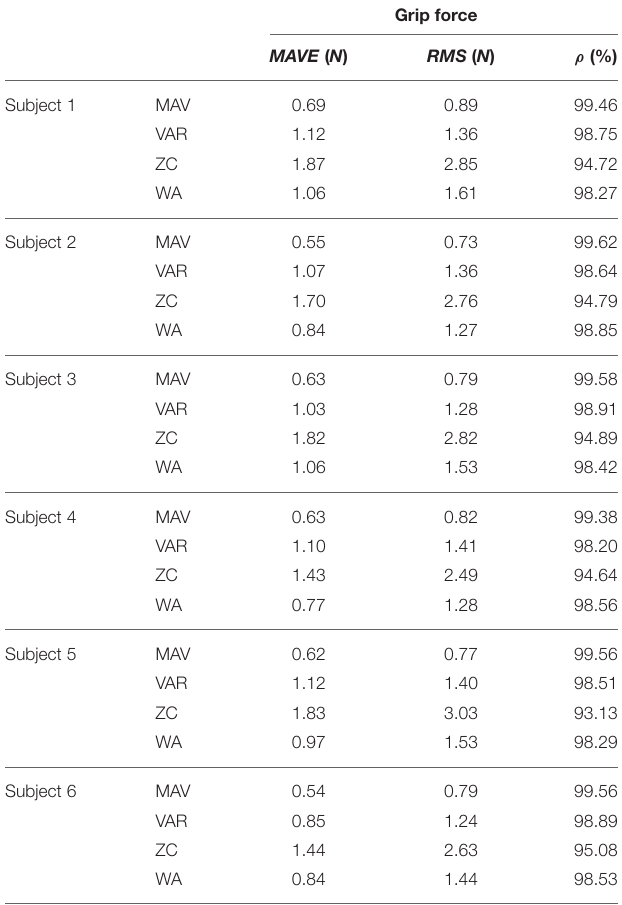
TABLE 3 | The results of the grip force estimation experiments.